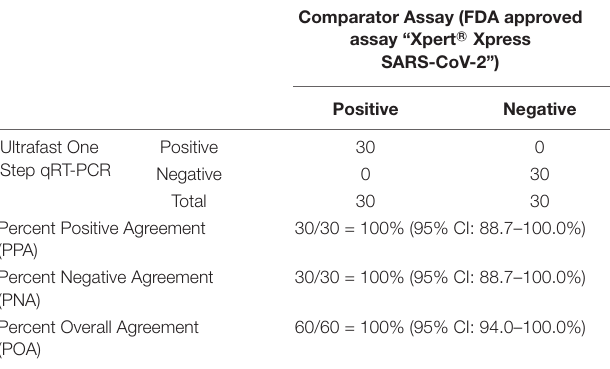
To evaluate the performance of the ultrafast one-step qRT- PCR in a clinical setting, we performed a blinded and randomized study with 30 SARS-CoV-2–positive and 30 SARS-CoV-2– negative nasopharyngeal swab samples obtained from